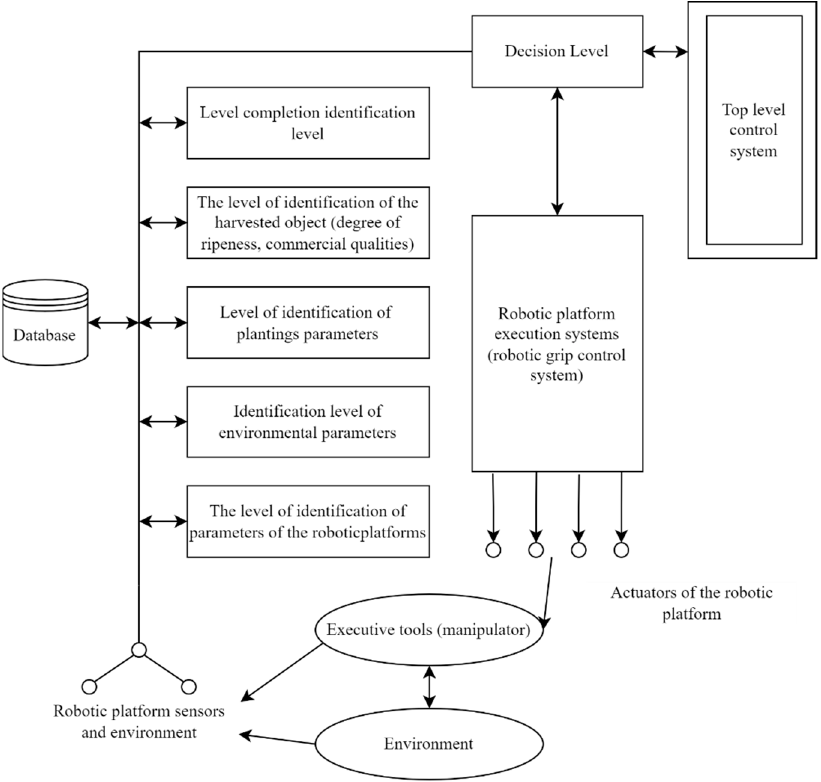
Figure 19. The structure of the method of hierarchical complex processing of on-board data.